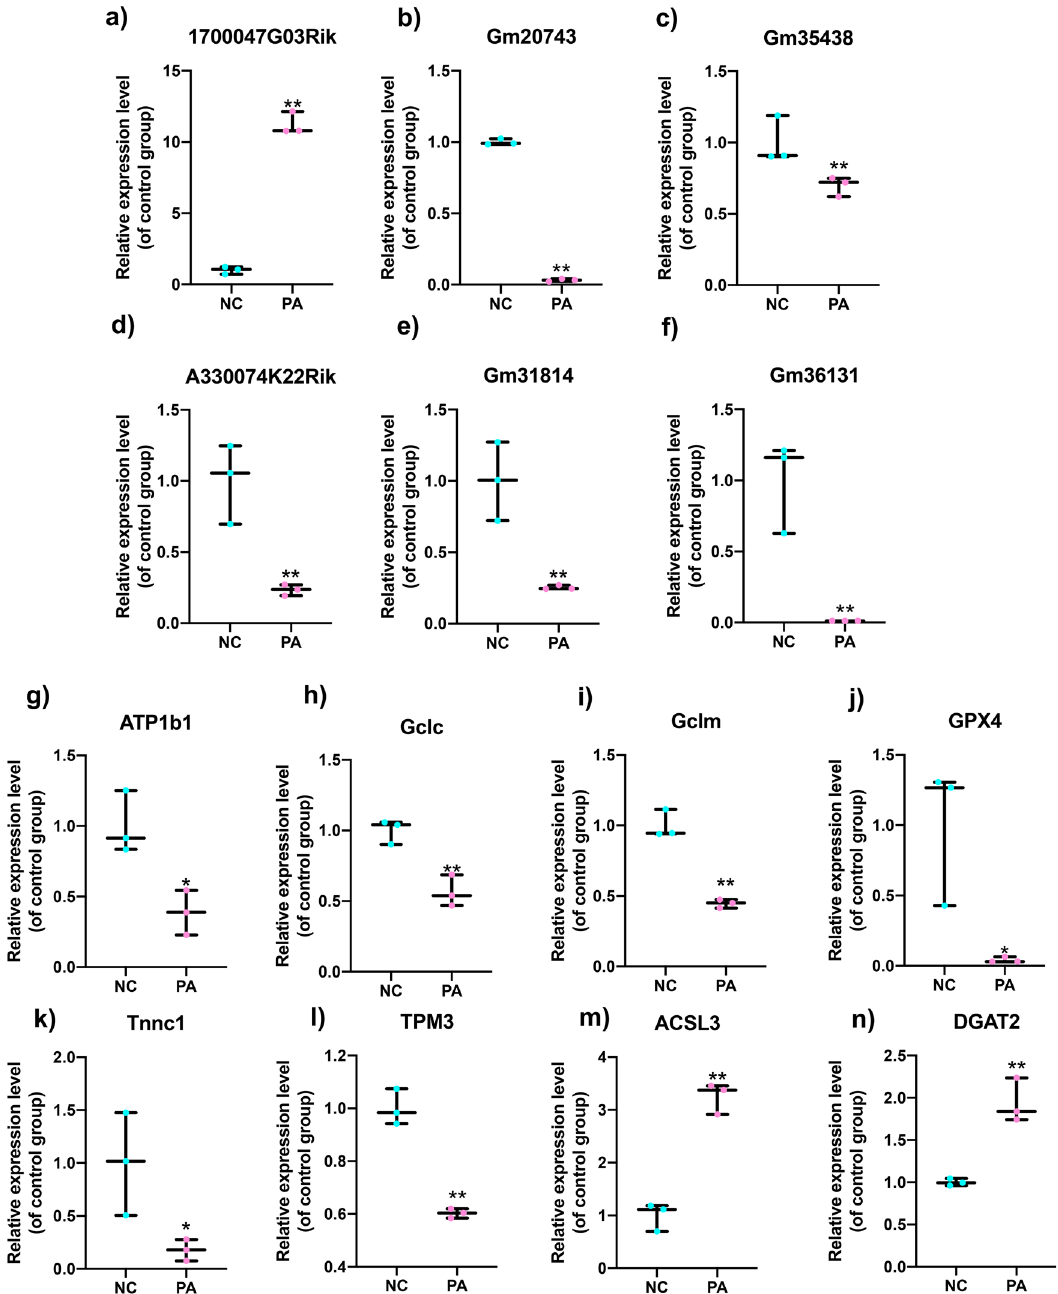
Fig. 6 Validation of the expression of dif-lncRNAs and dif-mRNAs in C2C12 cells exposed to PA. The relative expression of dif-lncRNAs (|log2 FC | > 1, expression >2 and q-value < 0.01) was detected in PA-induced C2C12 cells compared with NC group ( a – f ). The relative expression of highly correlated dif- mRNAs involved in the co-expression network was detected in PA-induced C2C12 cells and the control group ( g – n ). Data were expressed as mean ± S.D. * P < 0.05 ** P <